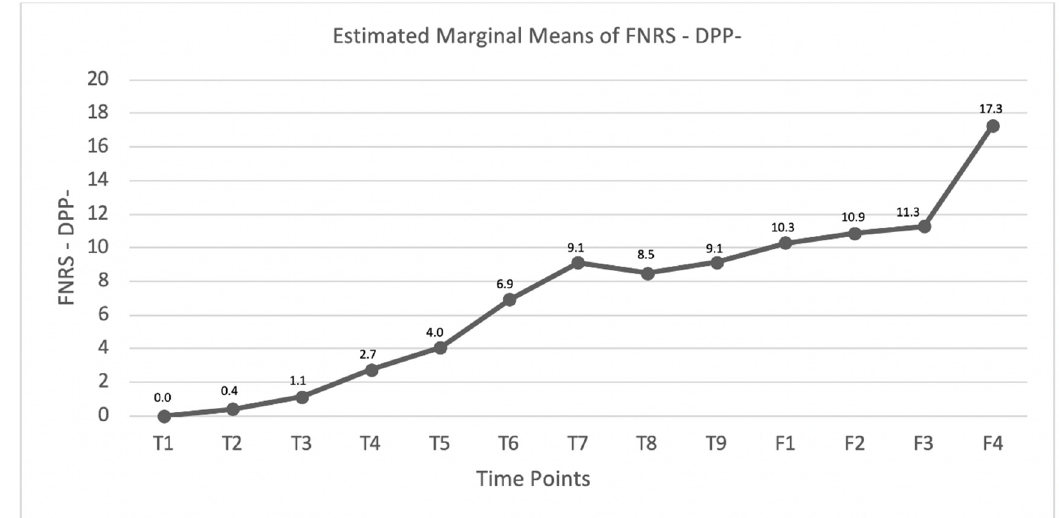
Figure 9. Graphic describing the FNRS-DPP − mean evolution within the DPP − dogs in the study group (SG). T1: admission, T2: day 3, T3: day 7, T4: day 15, T5: day 30, T6: day 45, T7: day 60, T8: day 75, T9: day 90, F1: 8–10 days follow-up, F2: 1-